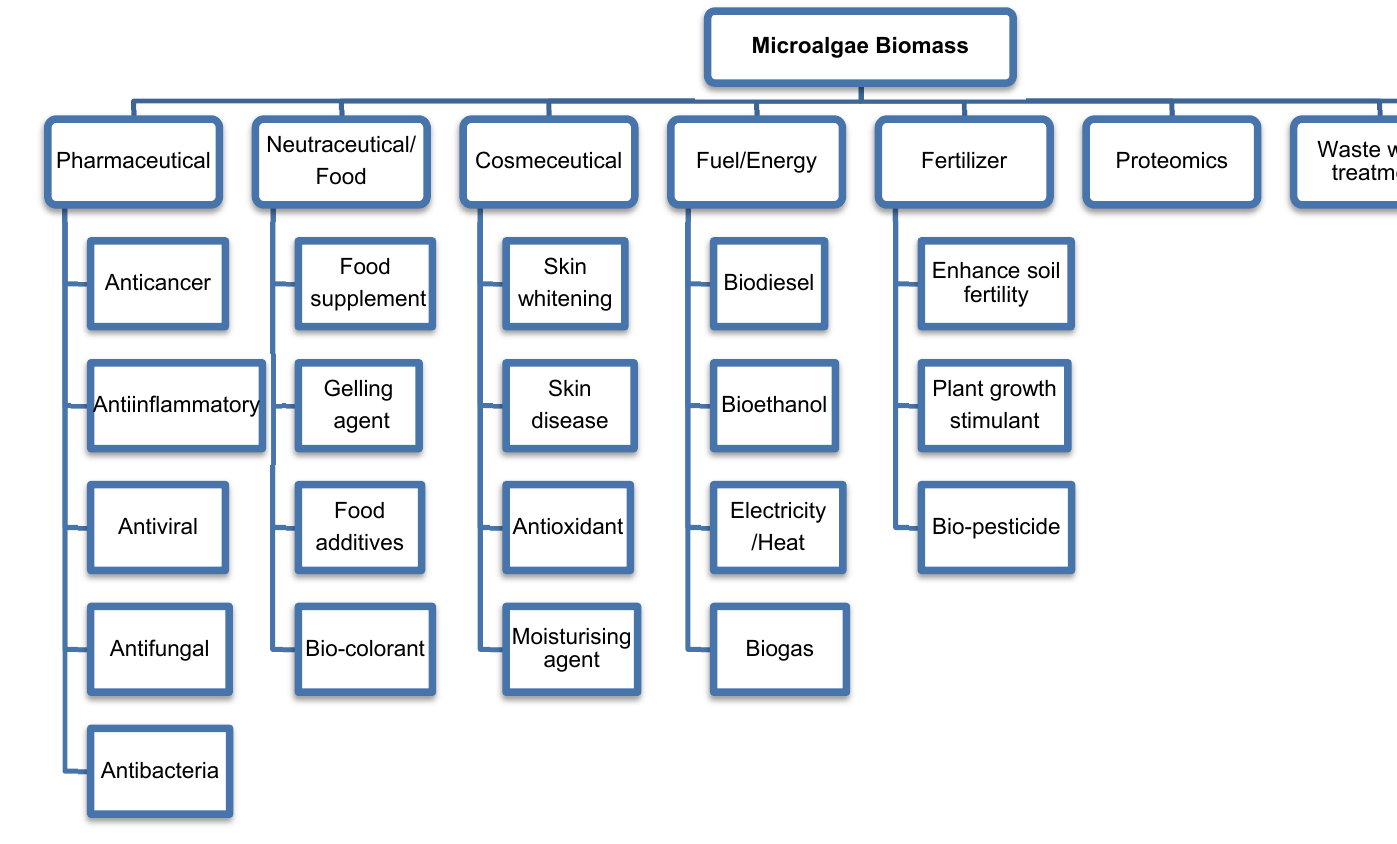
Figure 1. Potential uses of microalgae in various industries.